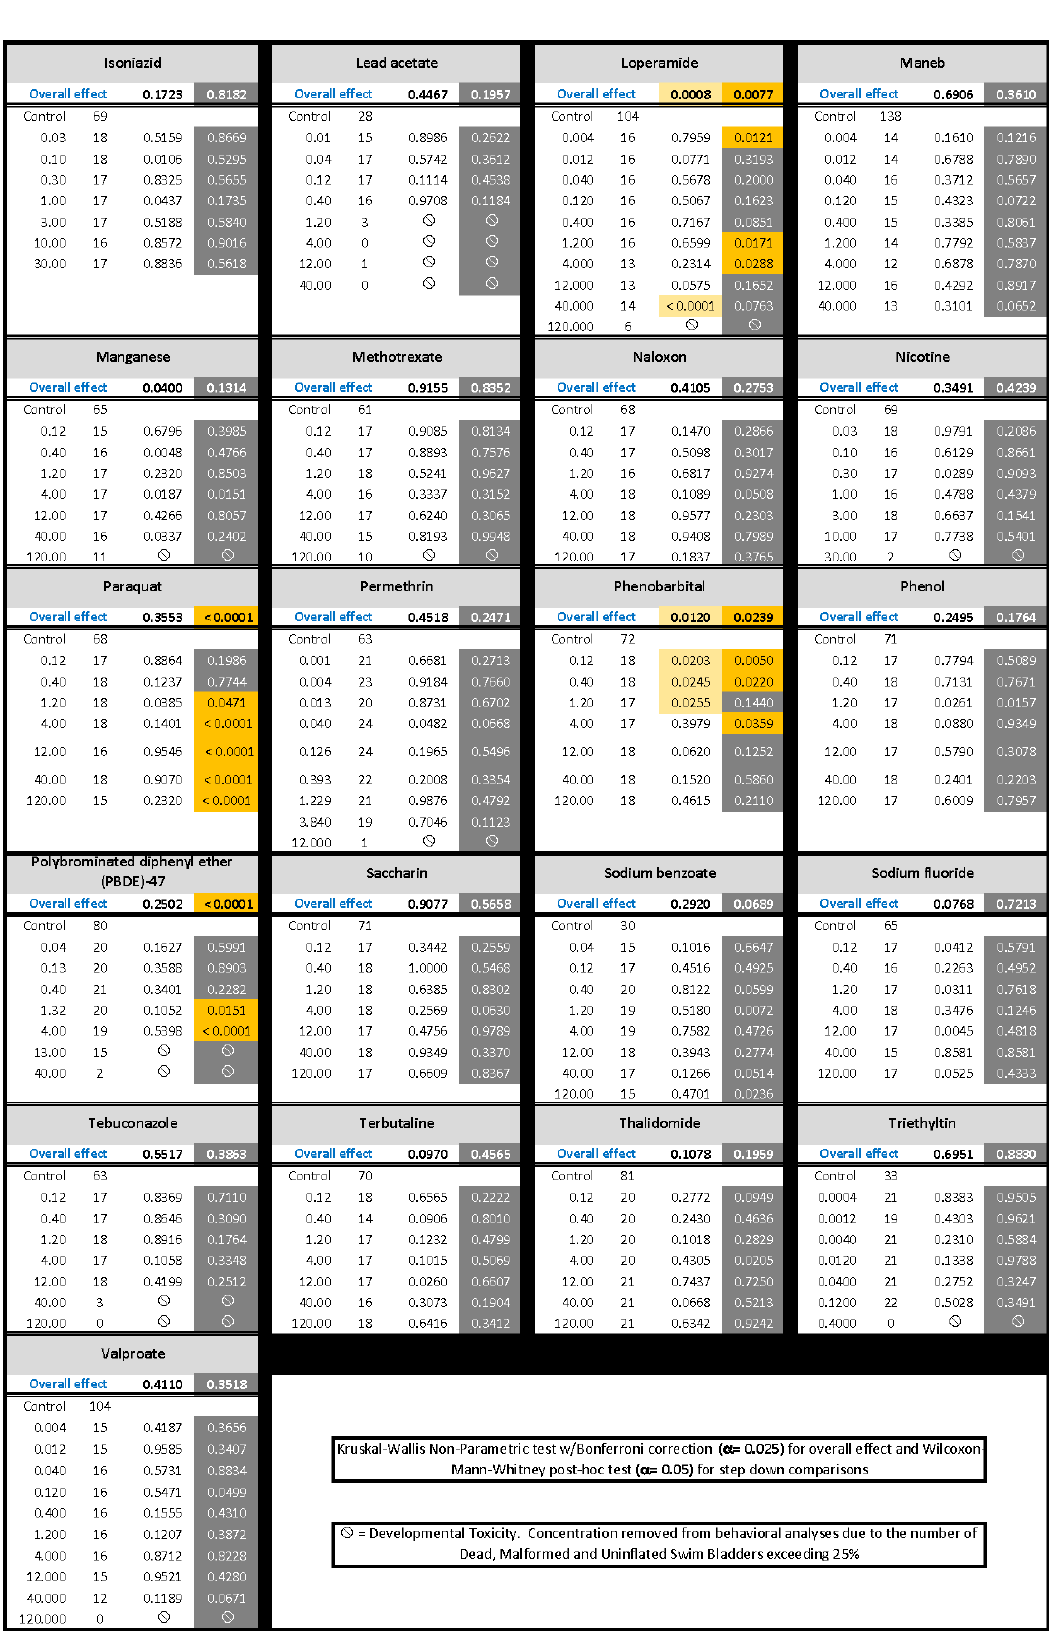
Figure 3. Behavioral Nonparametric Statistics Results. Results of the Kruskal-Wallis Nonparametric test for each chemical. A Bonferroni correction was applied to the overall effect to account for the